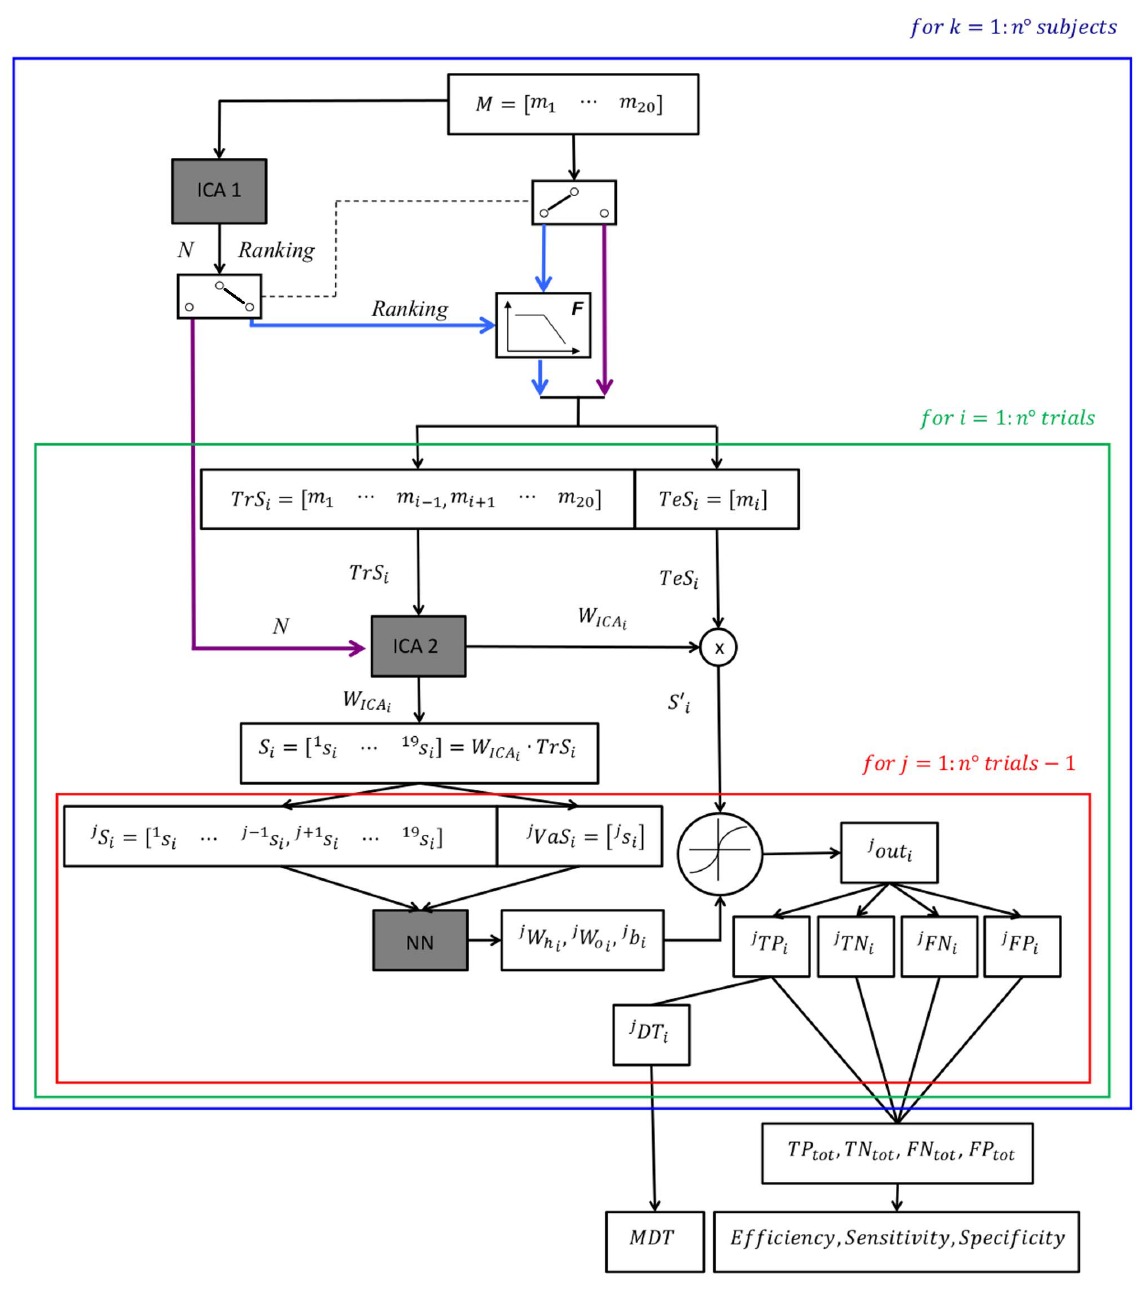
Figure 2. Algorithm. The scheme shows the entire algorithm used in this study. The red, green and blue boxes represent respectively the inner LOOCV , the outer LOOCV steps and the repetitions for all the subjects. The gray boxes represent the main core of the algorithm (i.e., ICA1 , ICA2 and NN ). The two switches are rigidly interconnected (dotted line) and allow the flow of information coming from the upper layers of the algorithm to go through either the purple lines (i.e., it occurs when the algorithm processes the dataset accounting for all body segments; see the section titled Processing of the datasets accounting for all segments ) or the blue lines (i.e., it occurs when the algorithm processes the dataset accounting for a subset of all body segments; see the section titled Processing of the datasets accounting for a subset of all segments ). Note that when the switches are commuted toward the purple (blue) lines no information can go through the blue (purple) lines, that is, the unselected lines are neglected by the algorithm. M is the initial dataset constructed by concatenating data related to the 20 collected trials and is preliminarily parsed out by ICA1 to determine the optimal number N of retained ICs and the Ranking concerning their informativeness. These information were respectively used to run the ICA2 either on the dataset accounting for all body segments (purple line) or on that accounting for a limited number of segments (light blue line). In this regard the box F selects the subset of segments being processed according to their Ranking . Then, 19 out of 20 trials (Training Set– TrS i ) are selected to train the model, whereas the excluded trial (Test Set– TeS i ) is used to test its performance. This procedure is repeated 20 times (‘‘outer’’ LOOCV ) leaving a different trial as TeS i each time (i.e., 20 TrS i and 20 TeS i for each subject– see green box). In order to train the model, ICA2 is performed on the TrS i with the number of components previously determined. ICA2 produces a time-invariant matrix ( W ICAi ) which is used to project both the TeS i and the TrS i into the independent component space. The resultant projected TrS i ( S i ) is passed on to the Neural Network ( NN ). A further LOOCV step (inner LOOCV ) is applied to S i (19 trials): 18 of them ( j S i ) are selected to train the NN , whereas the excluded trial (Validation Set – j VaS i ) is adopted to determine the optimal number of iterations. For each inner LOOCV iteration, the outputs of the NN box are the Bias ( j b i ) and the Weight